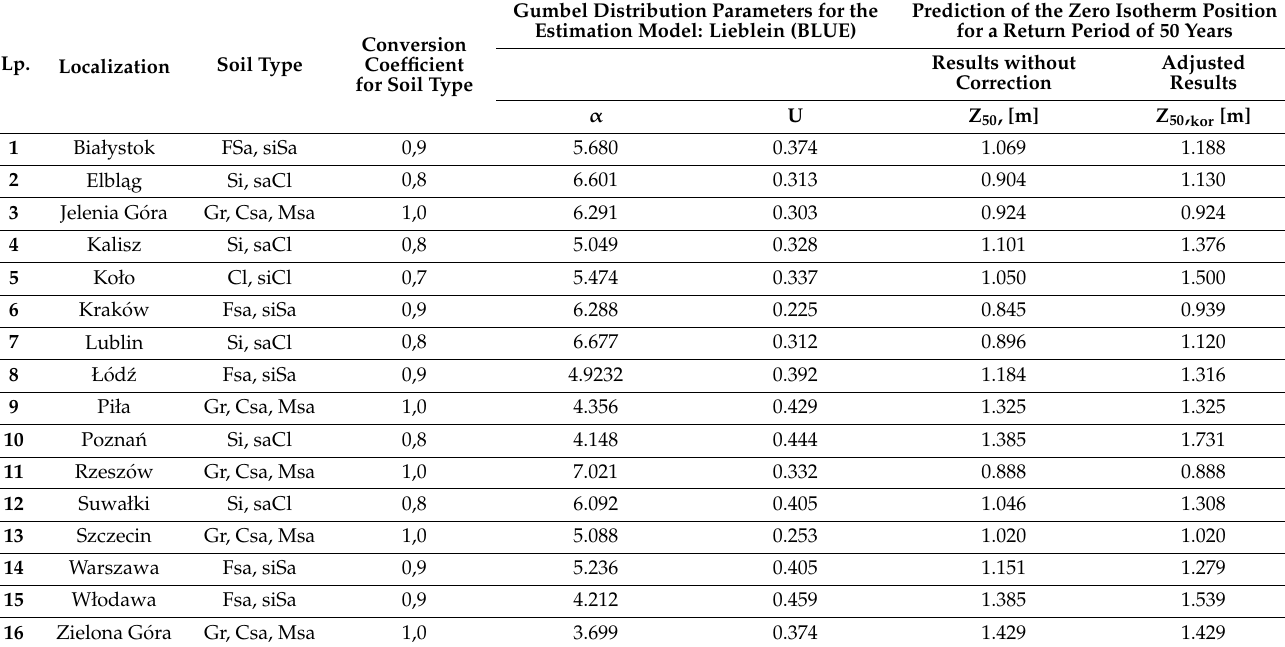
Table 1. Results of calculations for selected